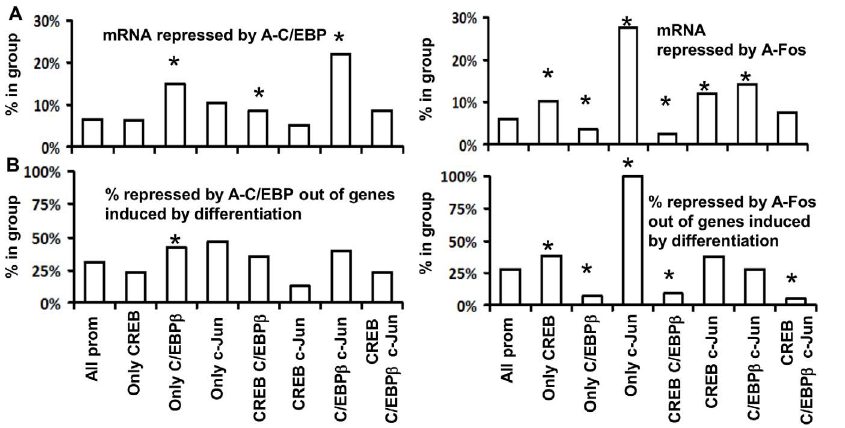
Figure 3. CREB binding is relatively low in the group of promoters bound by CREB, C/EBP b and cJun and induced by differentiation. A. Transcription factor binding distributions in all promoters, promoters bound by CREB, C/EBP b and c-Jun, and promoters bound by all three of these proteins that are also either induced or repressed upon differentiation. Columns show the mean value of the binding affinity for each of the three transcription factors in these four groups of promoters, while error bars show the 15% and 85% percentiles. The binding affinity of CREB is significantly lower in promoters bound by all three transcription factors and induced by differentiation. Number on top represents the p-value from an unpaired t-test. B. Chip-PCR for promoter regions of SPRP1A and DNAse1L3 induced by differentiation. CREB binding is low in comparison with C/ EBP b and c-Jun. 3 9 GAPDH region was not enriched in these samples.